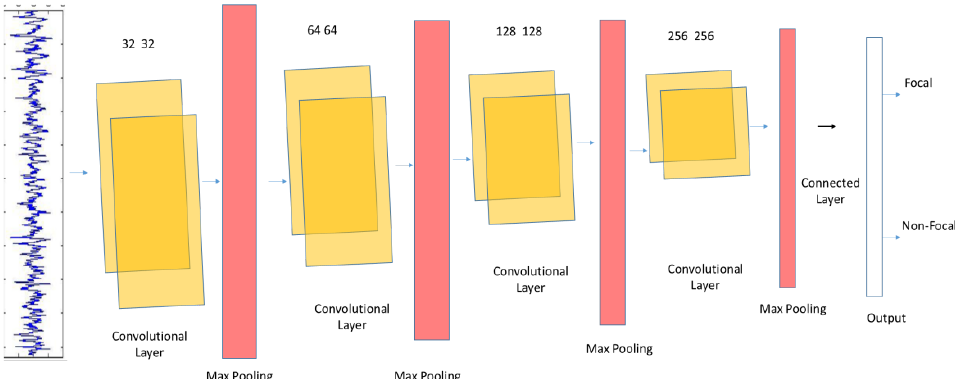
Figure 2. Architecture of 1D-CNN for classification of focal and non-focal using raw EEG signals, DWT features, and hybrid